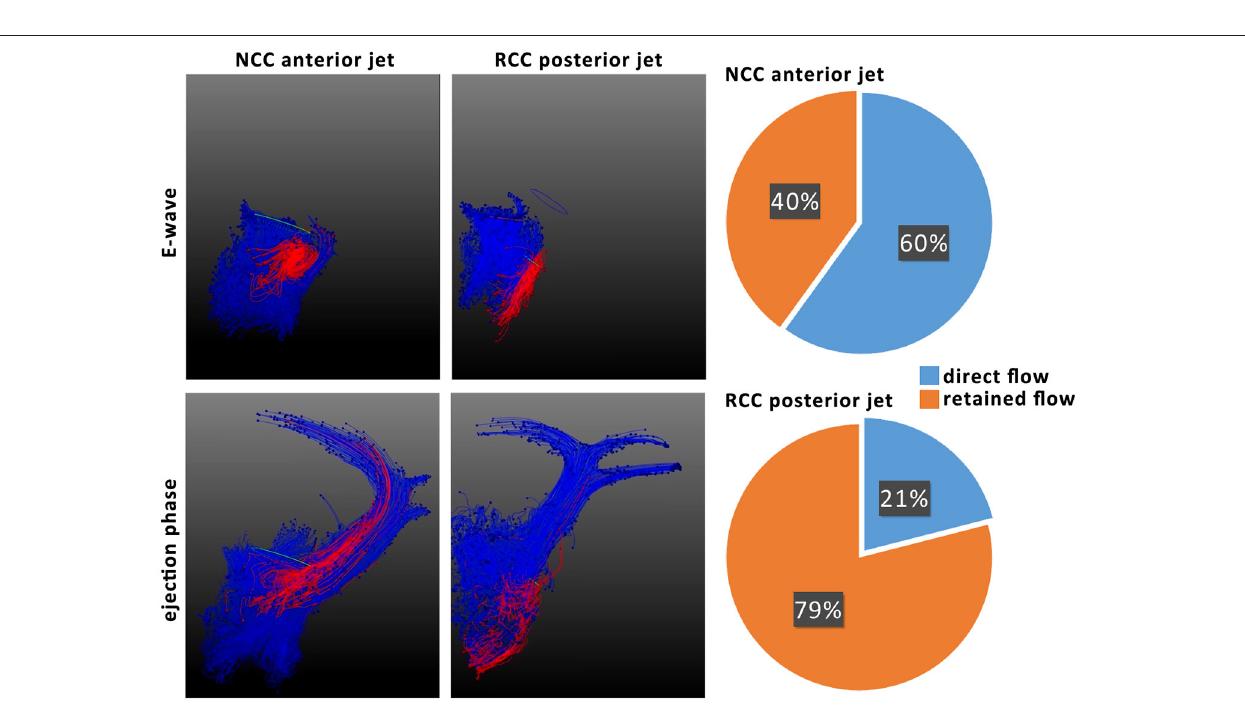
FIGURE 4 | Cross-sectional area of the anterior vortex for different long axis cut planes (according to Figure 2 ) for NCC (red circles), RCC (blue stars), and control (grey triangles) animals.